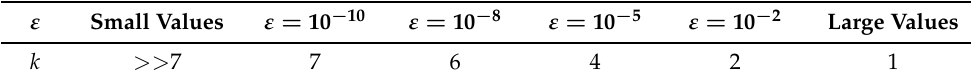
Table 3. The number of iterations for different values of ε based on the FPA.